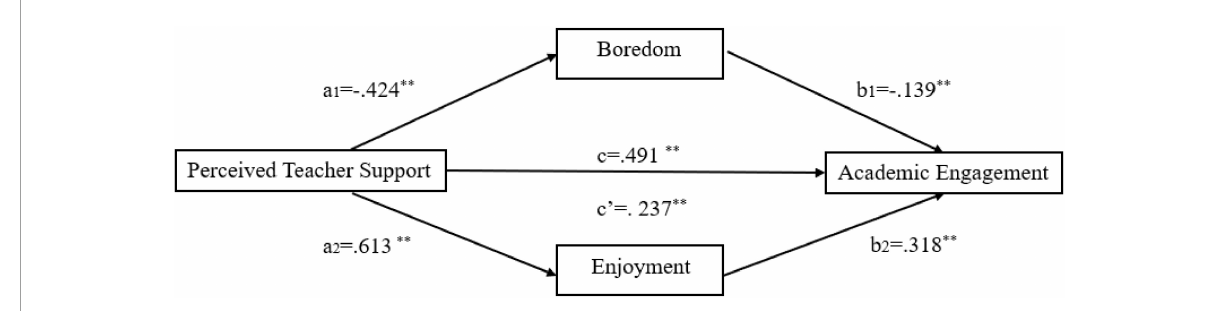
FIGURE1 Mediating effect of enjoyment and boredom between teacher support and